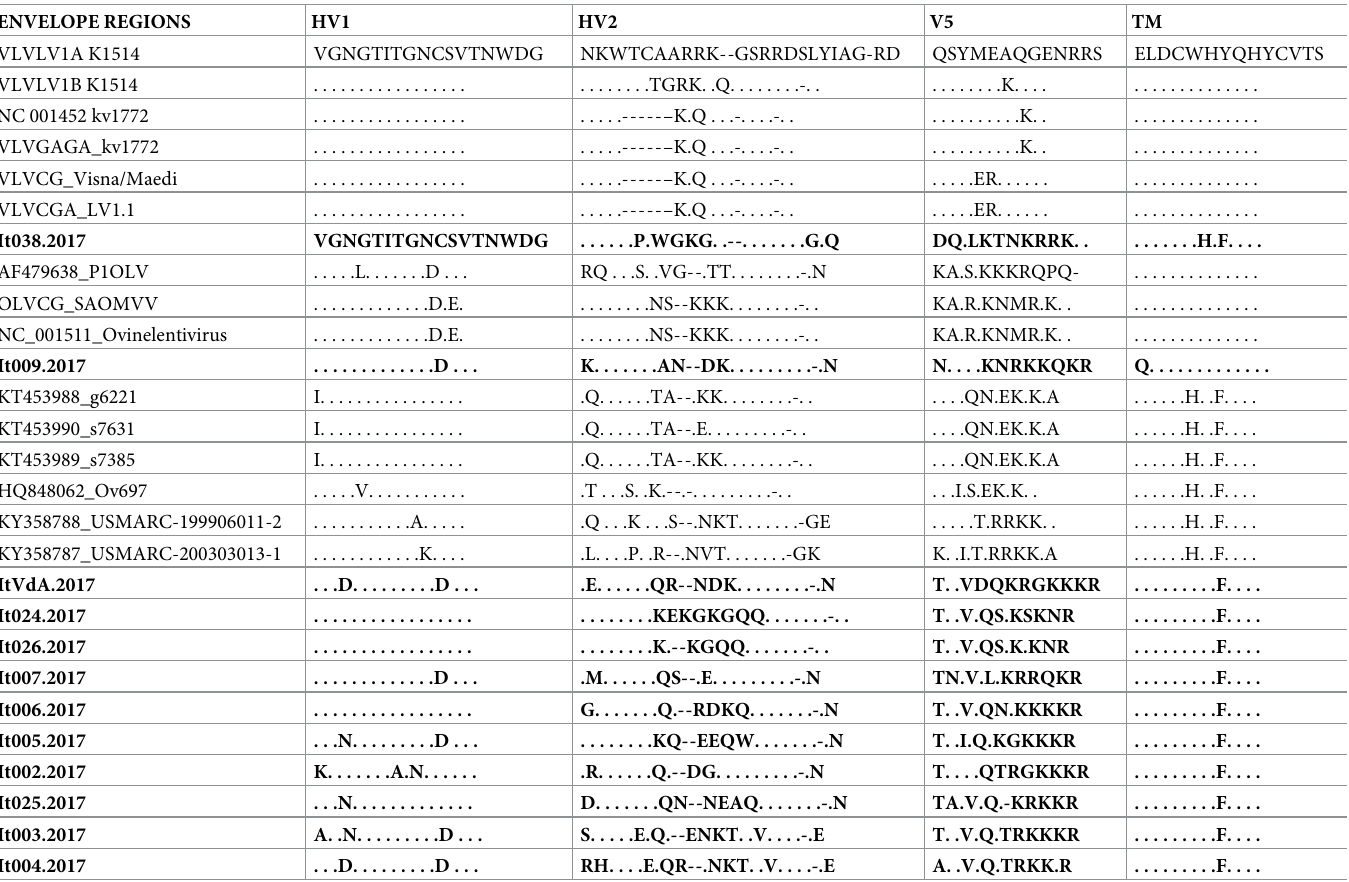
Table 3. Variable regions within env gene among SRLV A genotype strains. HV1 and HV2: hypervariable (HV) region; TM: transmembrane domain within env. ENVELOPE